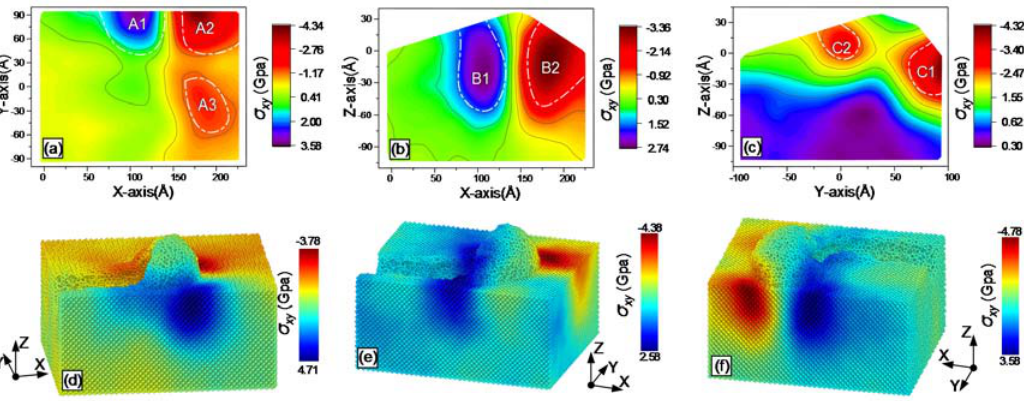
Figure 12. Snapshots of the shear stress σ xy after the atomic-scale curve grinding: ( a ) on X–Y plane; ( b ) on X–Z plane; ( c ) on Y–Z planes; ( d ) at the front point of the arc, ( e ) at the rear of the arc; and ( f ) at the end of the tool.